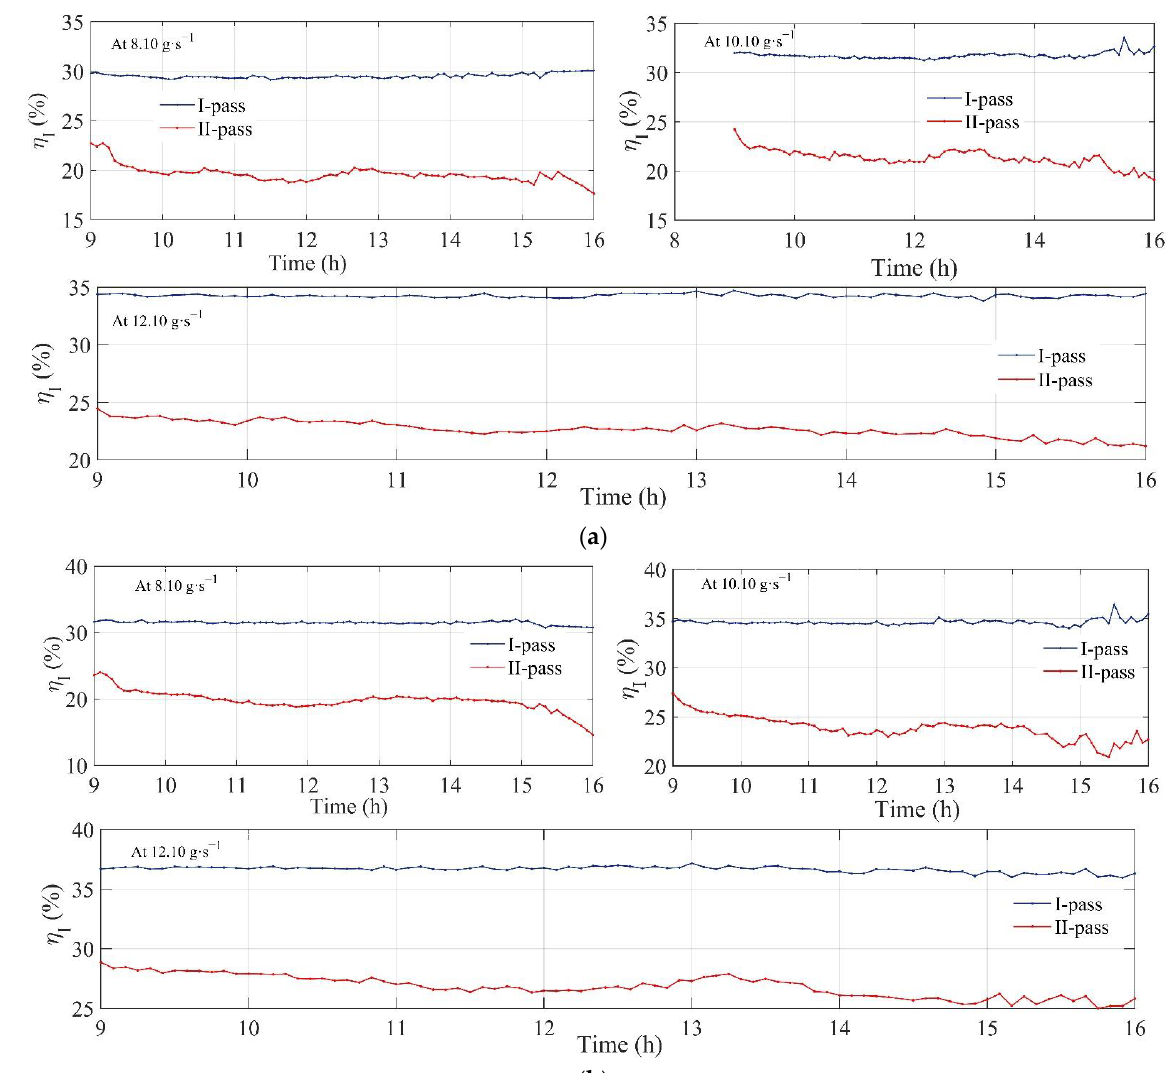
Figure 8. The variation in the first law efficiency, η I , of the two-pass solar air collector with time (( a ) Collector-I, ( b ) Collector-II) (( a ) Collector-I, ( b ) A massive jump of 155.88% in η I was calculated between two passes of Collector-II.